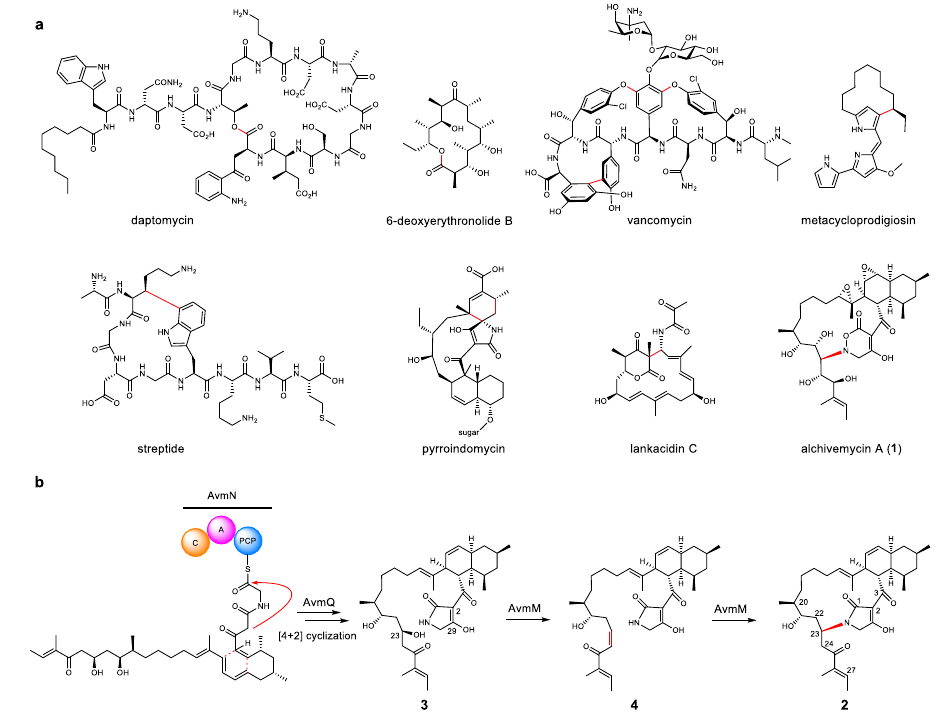
Fig. 1 | Macrocyclic reactions involved in natural product biosynthesis. a Representative macrocyclic natural products formed through diverse strategies. New bonds formed through macrocyclizations are highlighted in red. The macro- cycles are formed by TE-tethering in daptomycin and 6-deoxyerythronolide B, a cytochrome P450 in vancomycin, a rieske oxygenase in metacloprodigiosin, a radicalSAMinstreptide,adualfunctionenzymecatalyzinganamideoxidationand